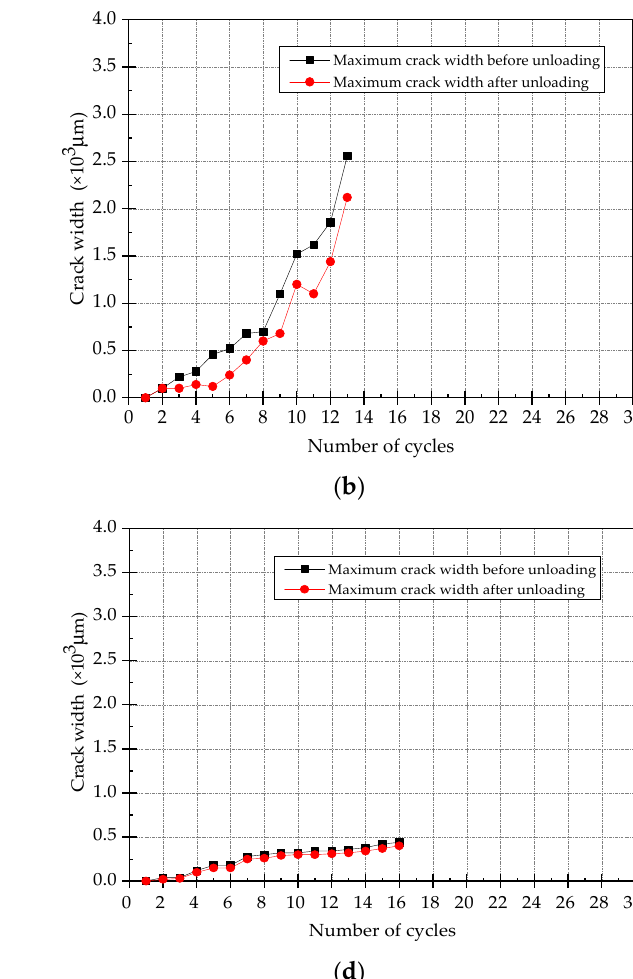
Figure 12. The curves of maximum fracture width under loading and unloading. ( a ) SJ-1; ( b ) SJ-2; ( c ) SJ-3; ( d )